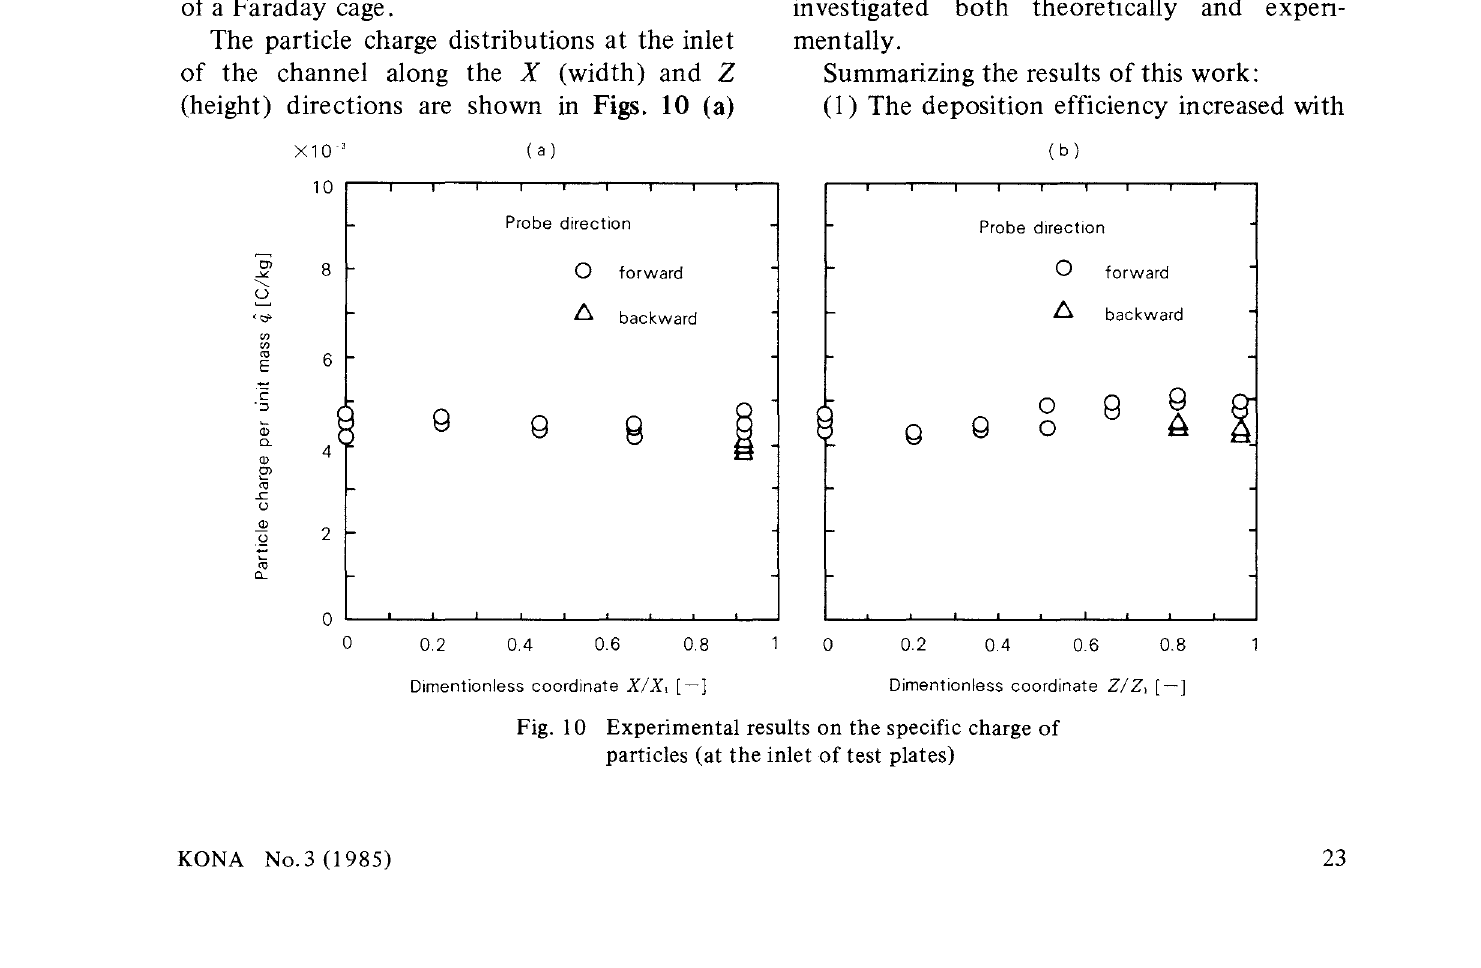
Fig. 9 Experimental relationship between deposition efficiency and the spacing of plates